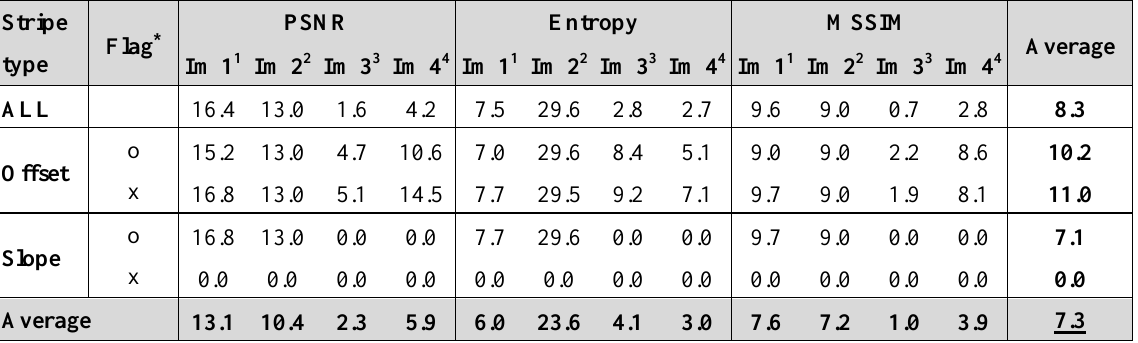
Table 1. Average deviation of the 1600 destriped images from ground truth [%].